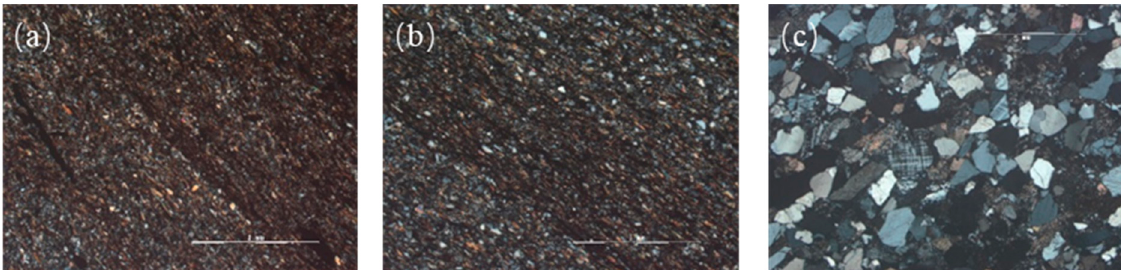
Figure 3. Characteristics of gangue under transverse polarized light microscopy ( a ) MS14; ( b ) MS15; ( c ) MCS16. ( c )